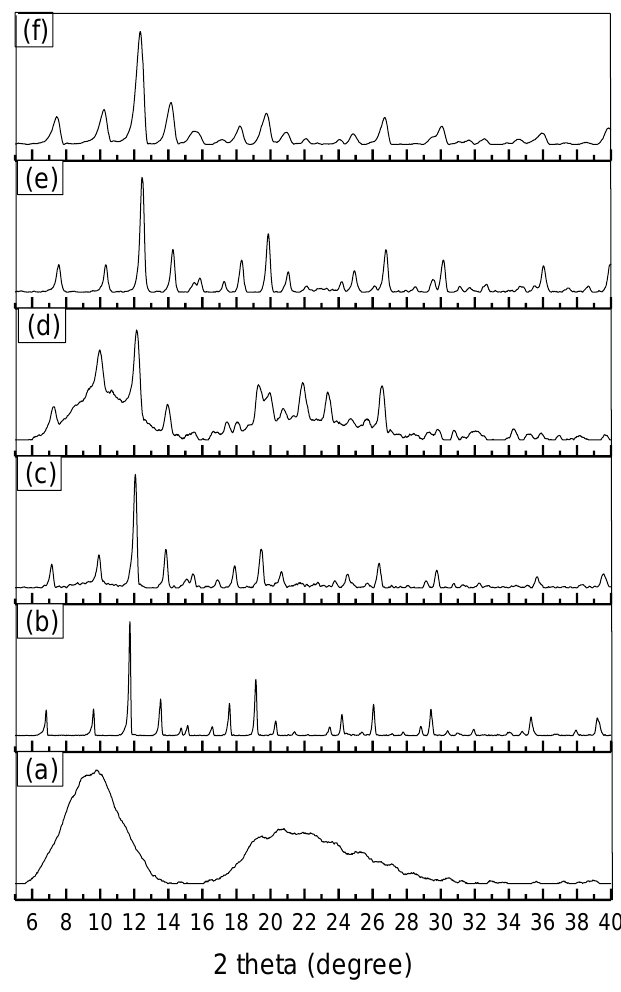
Figure 5. PXRD of ( a ) woolen fabric (untreated); ( b ) HKUST-1; wool@HKUST-1 synthesis of: ( c ) 24 h; ( d ) 24 h washed; ( e ) 48 h; and ( f ) 48 h washed.